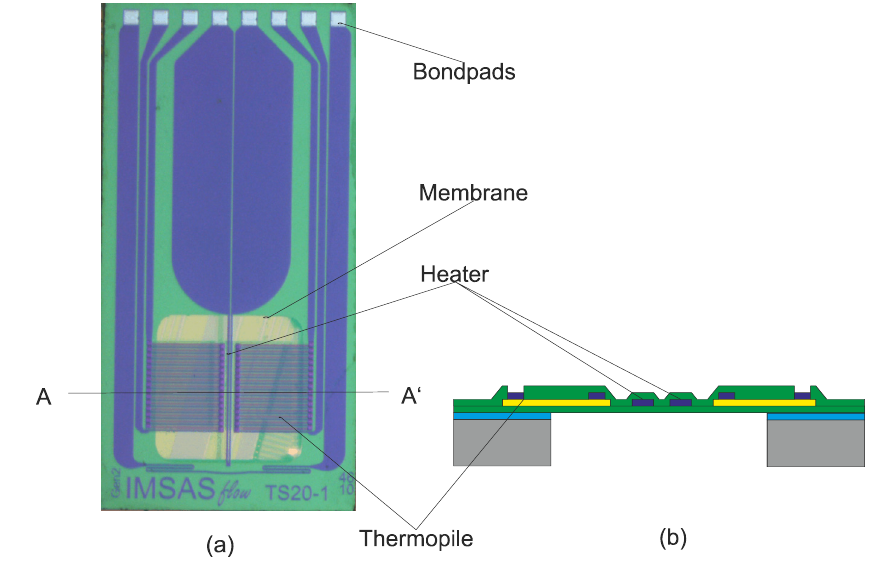
Figure 1. (a) An example of Institute for Microsensors, Actuators and Systems (IMSAS) thermal flow sensors. (b) A cross section according to (AA’) of the